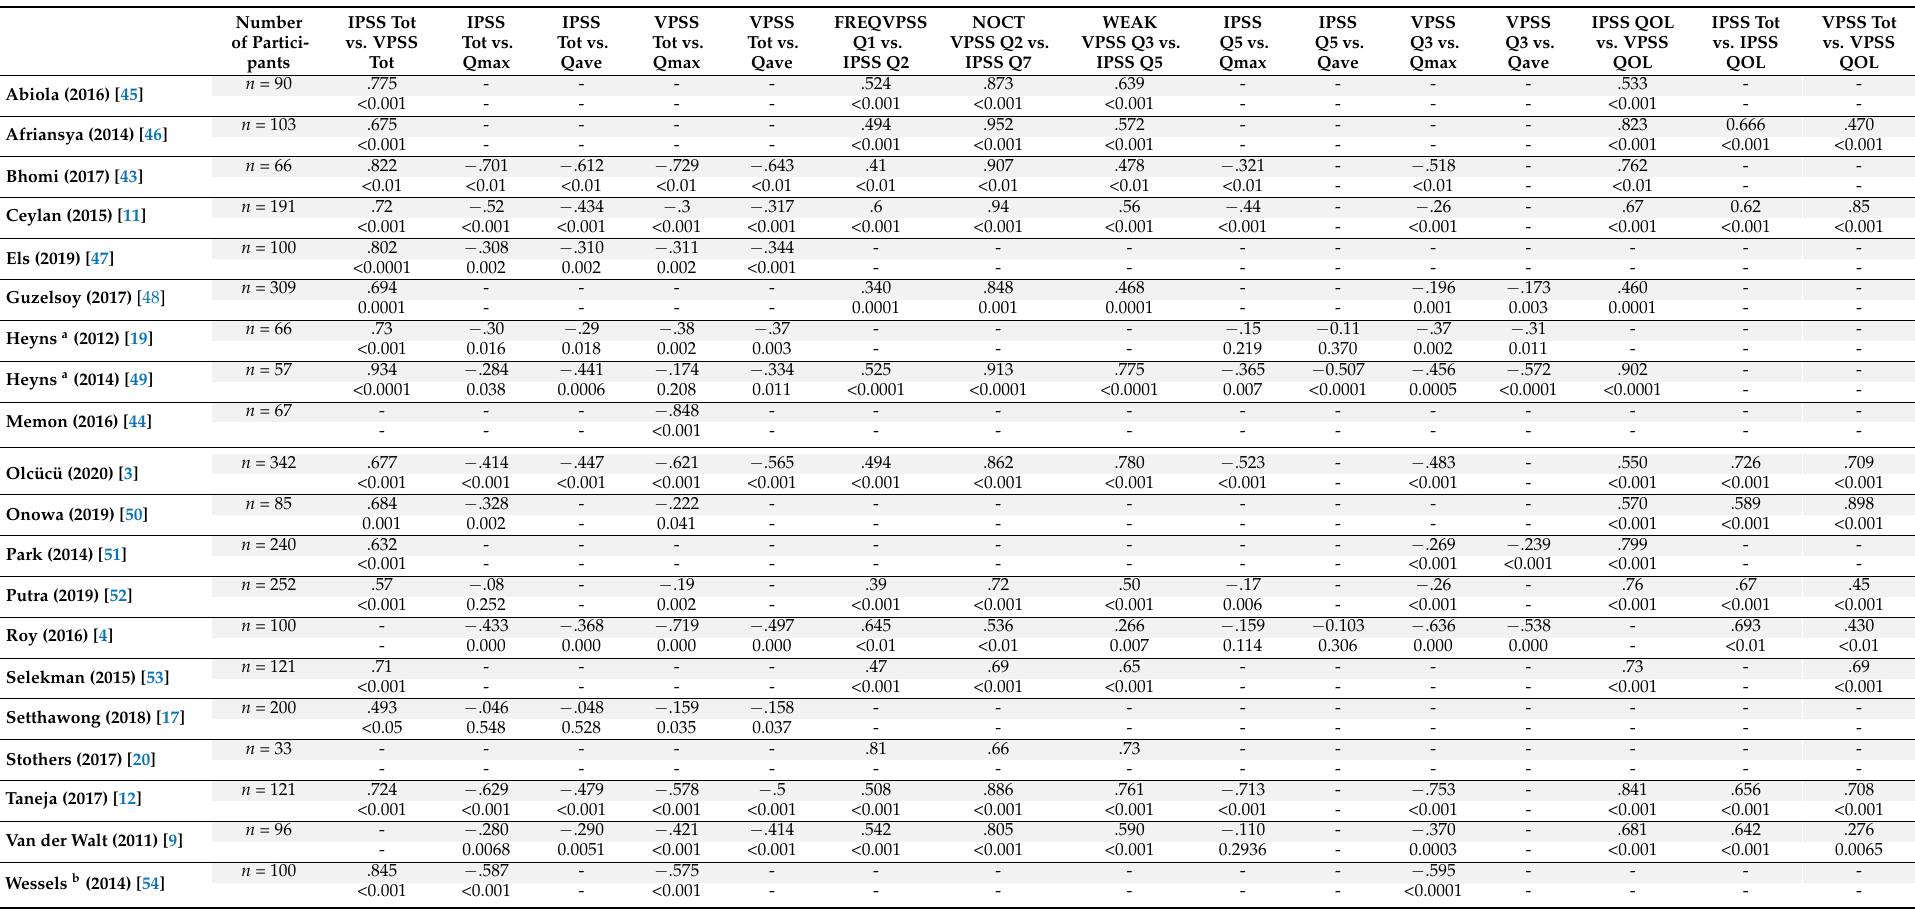
Table A1. Correlations between IPSS scores and VPSS and uroflowmetry parameters in earlier studies. All correlations presented are nonparametric Spearman’s rank order correlations, except for the parametric Pearson’s product–moment correlations presented in Bhomi (2017) [43], Memon (2016) [44] and Taneja (2017)